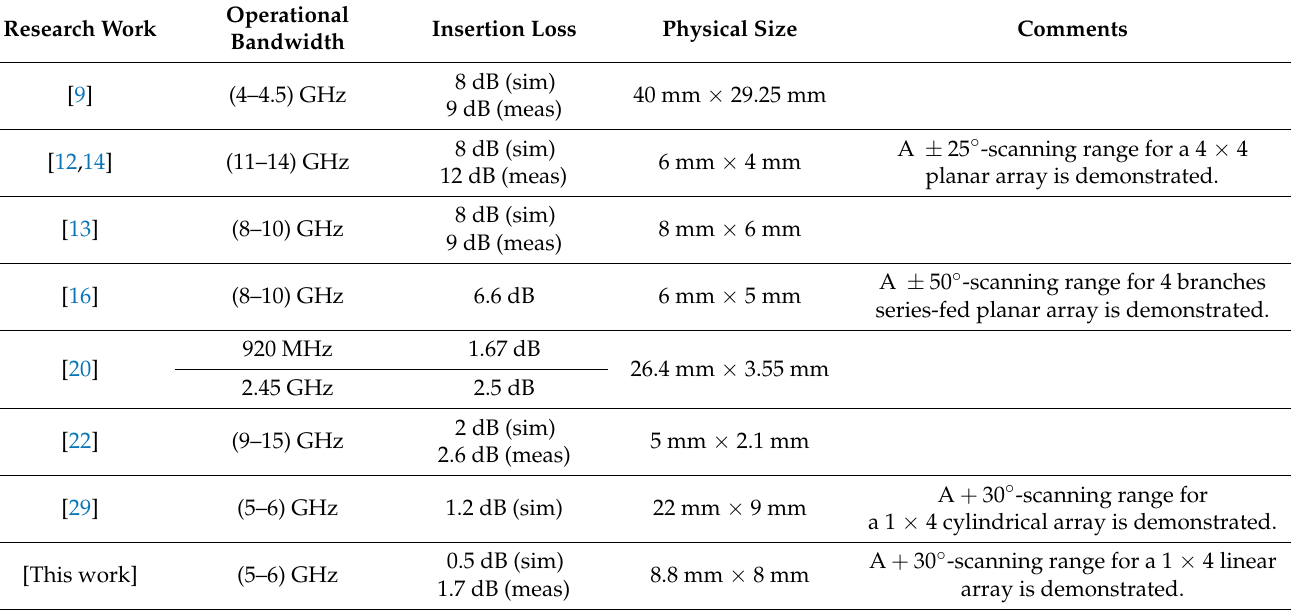
Table 3. Quantitative comparison of the proposed work with selected existing